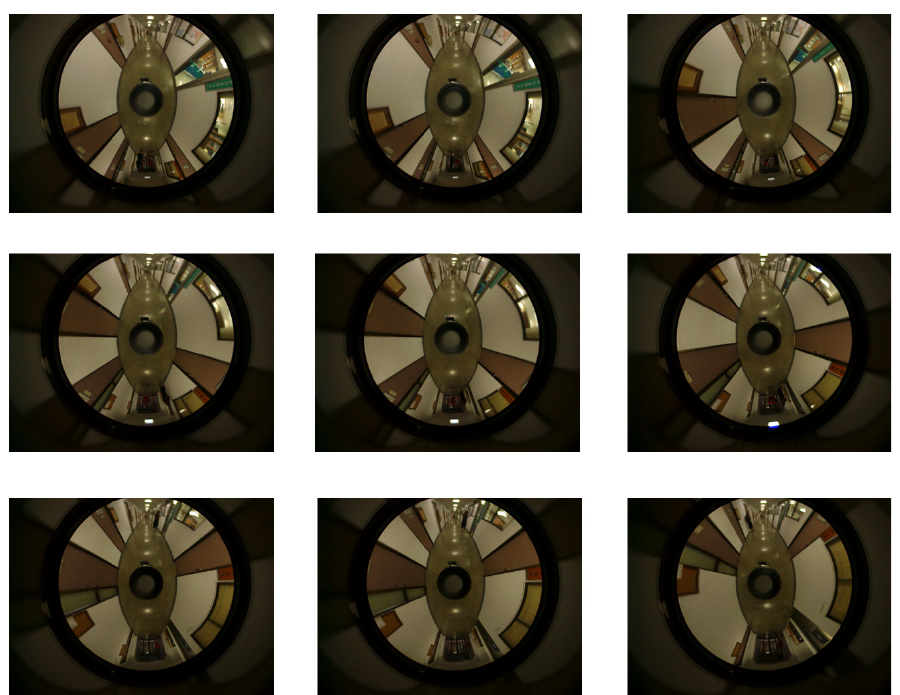
Figure 12. The omnidirectional images used for the mobile robot localization in the second experi- ment. The images were captured when the mobile moved on non-smooth ground to evaluate the self-localization capability.